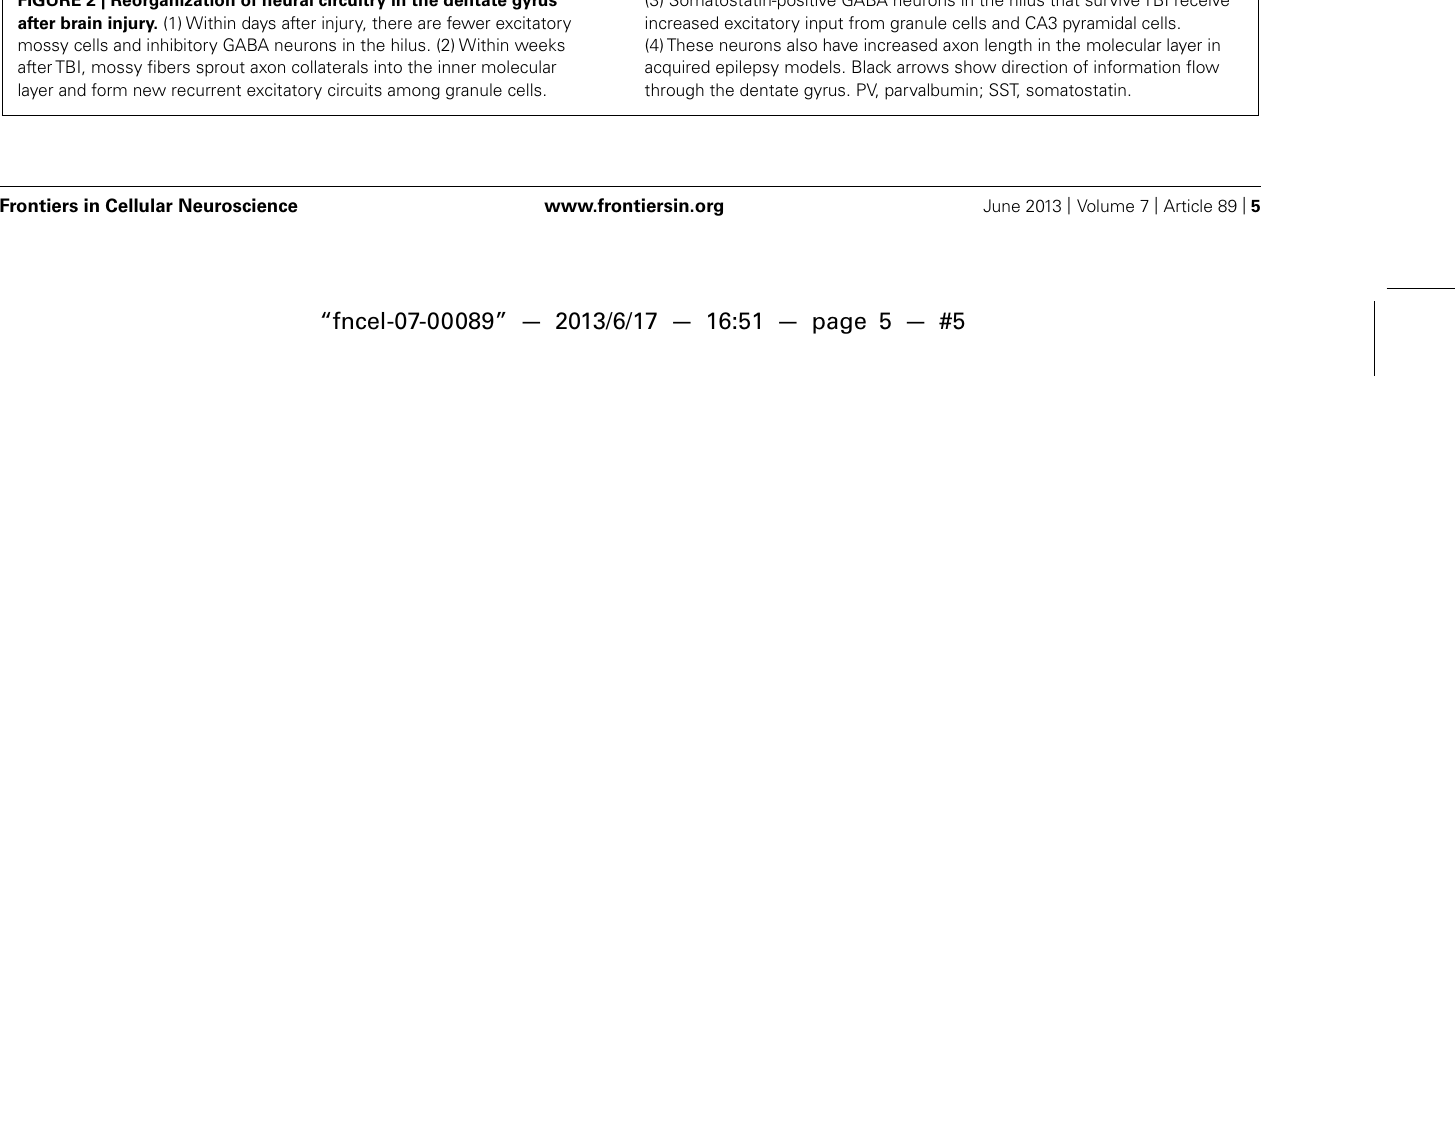
(3) Somatostatin-positive GABA neurons in the hilus that surviveTBI receive increased excitatory input from granule cells and CA3 pyramidal